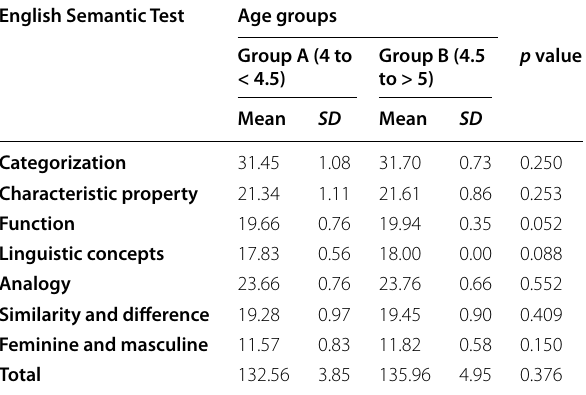
Table 3 Comparison between the two age groups regarding the total and subtotal scores of English Semantic